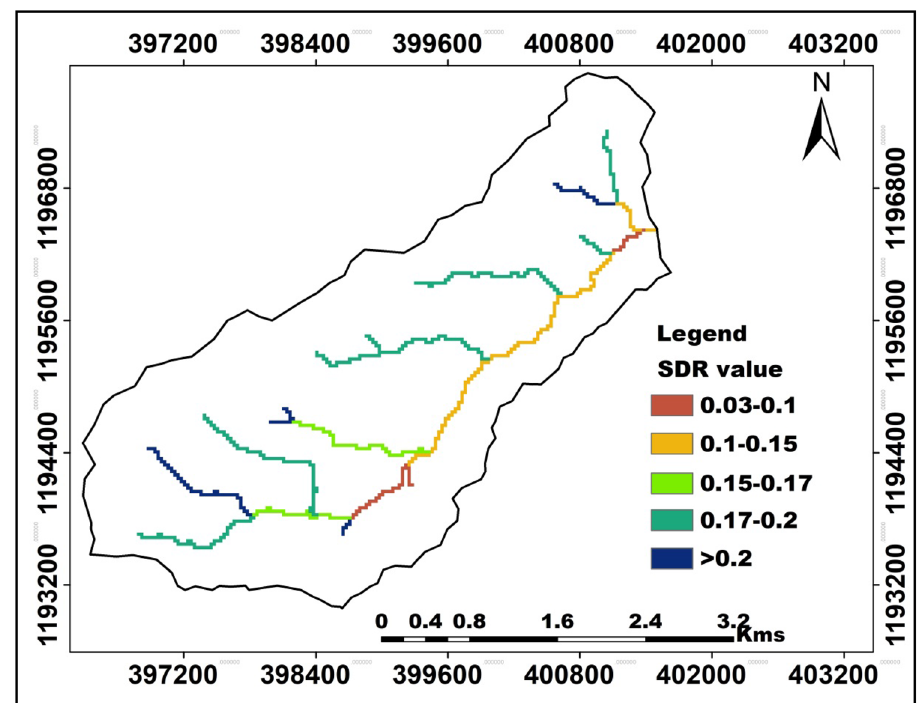
Fig. 8 Map of sediment deliv- ery ratio (SDR)